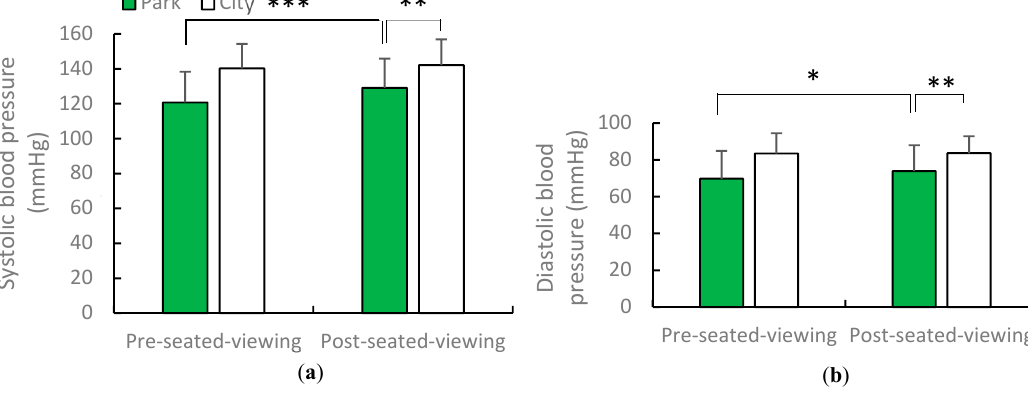
Figure 3. The average of blood pressure after urban park and city views in spring: a ) systolic blood pressure and b ) diastolic blood pressure. N = 12, mean ± standard deviation. * p < 0.05, ** p < 0.01, *** p < 0.001, determined by the paired t -test (one-sided).